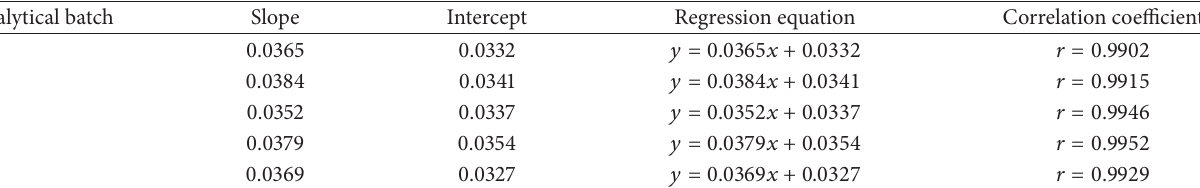
Table 2: Linearity for assay of aesculin in rat plasma.